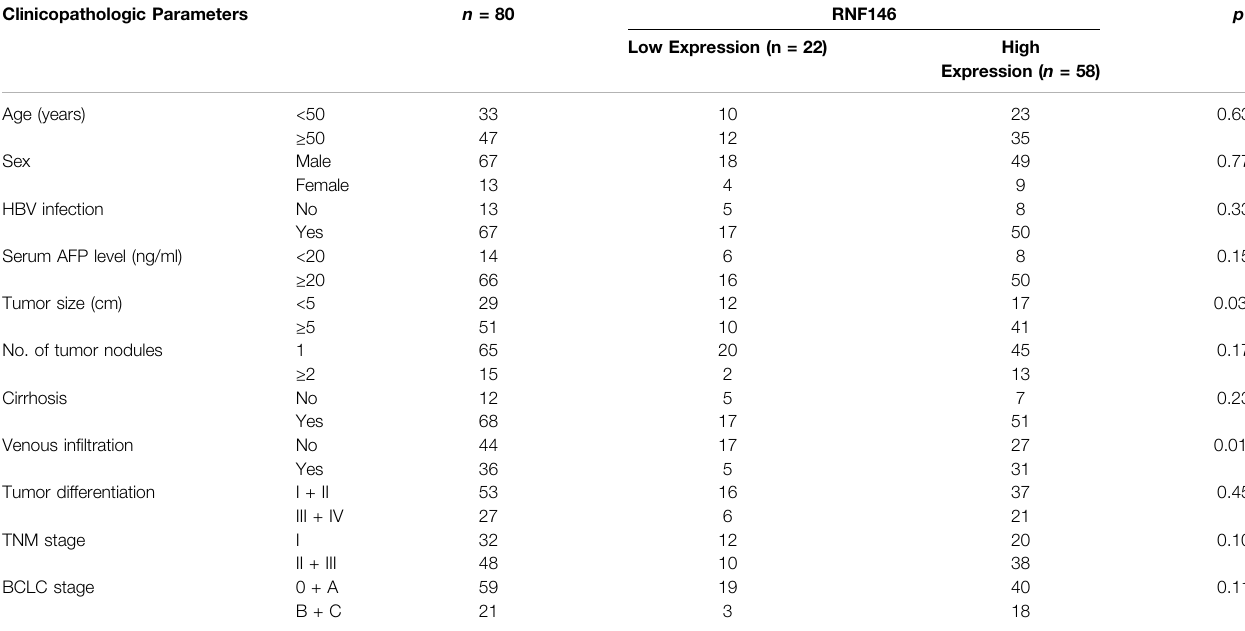
TABLE 1 | Relationship between RNF146 expression and clinicopathologic parameters of patients with hepatocellular carcinoma. Clinicopathologic